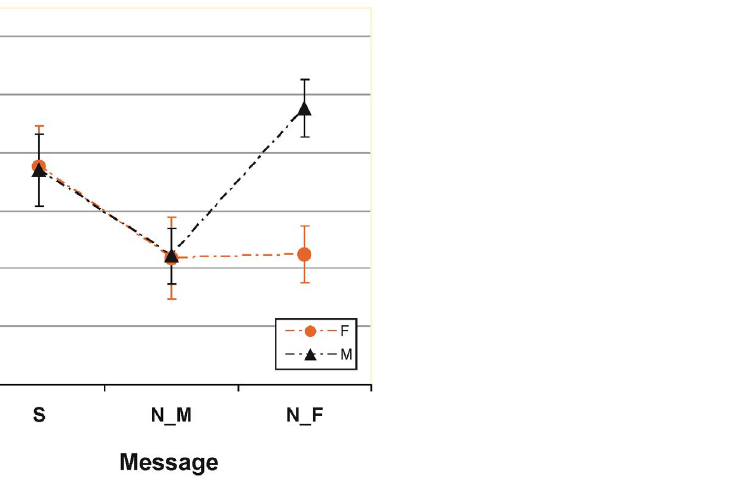
Fig. 1. Impact of explicit negative stereotype messages on the event arrangement (EA) test. Test scores for female (represented by orange circles) and male (represented by black triangles) participants in the groups with different information given prior to testing: S, standard instruction, gender neutral message; N_F, negative for females: ‘‘Females are usually worse on this task’’ – an explicit negative gender stereotype message for females, and N_M, negative for males, ‘‘Males are usually worse on this task’’ – an explicit negative gender stereotype message for males. Vertical bars represent ¡ SEM.